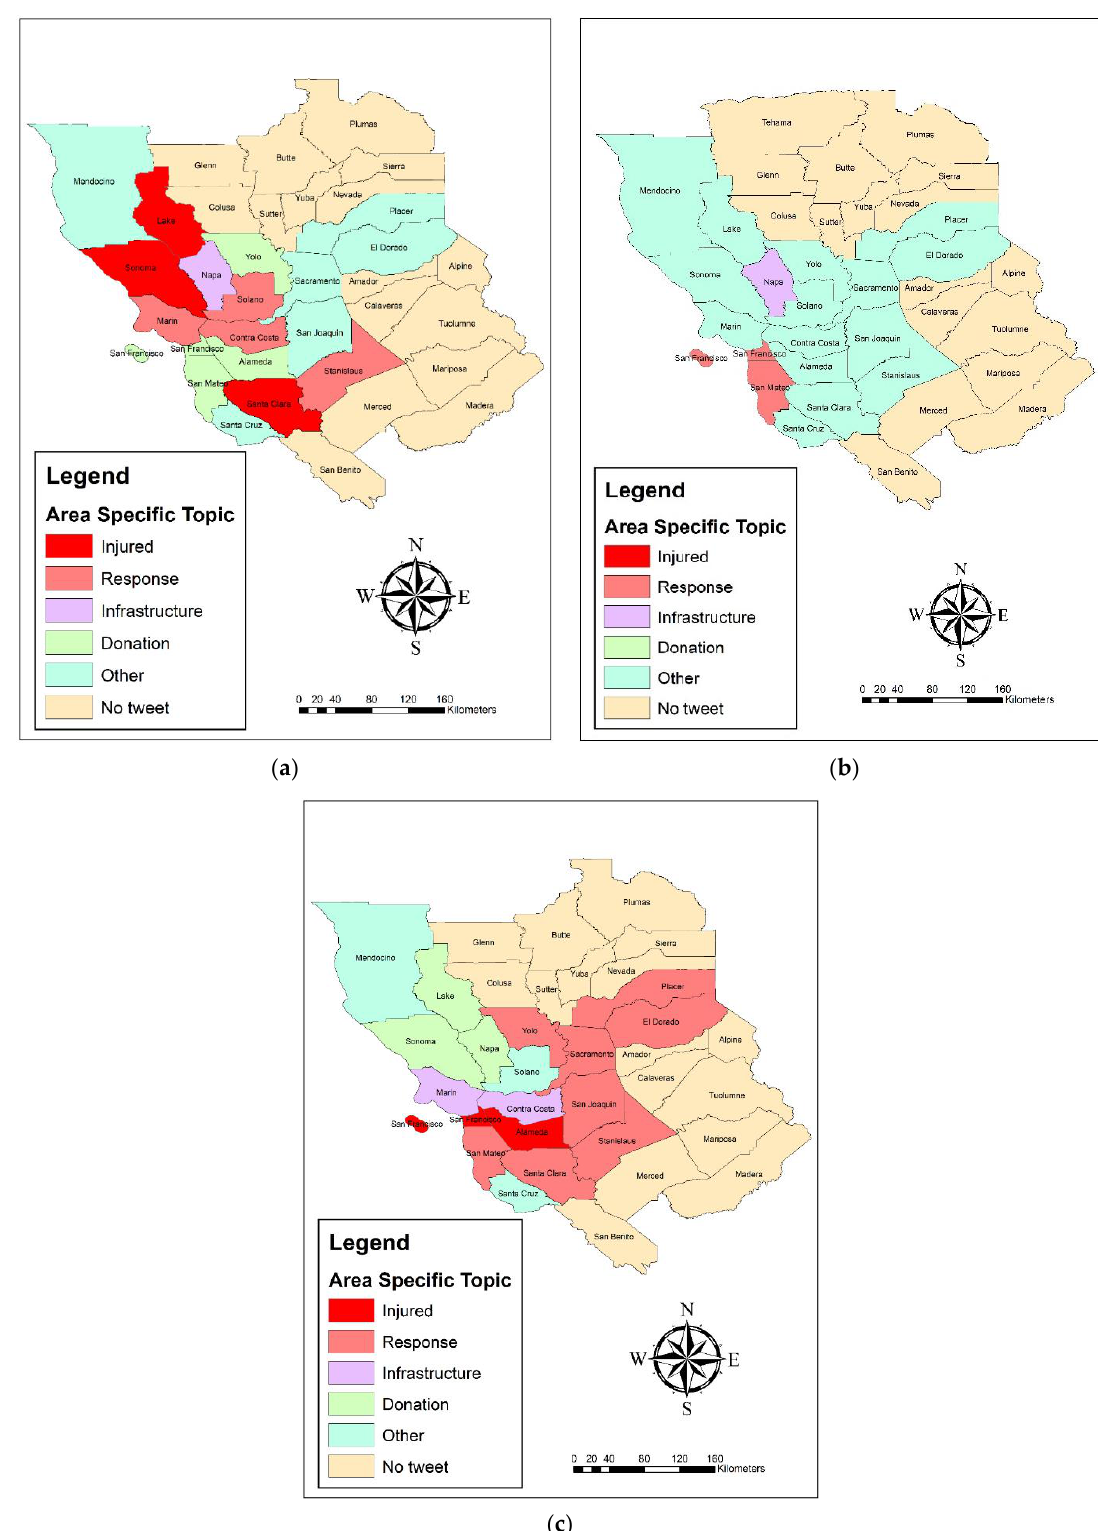
Figure 9. LQ analysis of the tweets spatial topic concentration at the county scale, classified by Naive Bayes ( a ), SVM ( b ), and deep learning ( c ) in five classes.